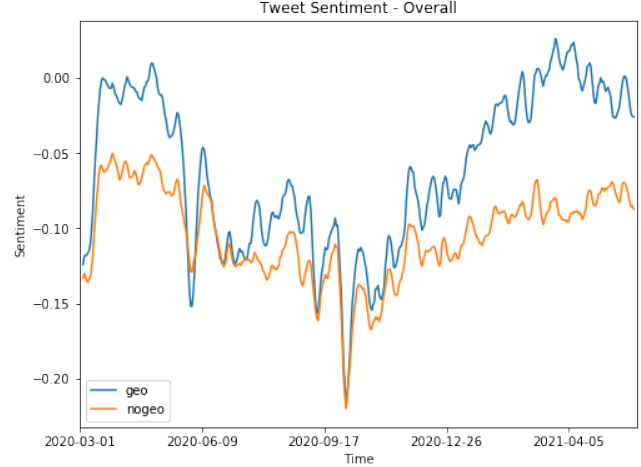
Figure 4. Overall daily sentiments.